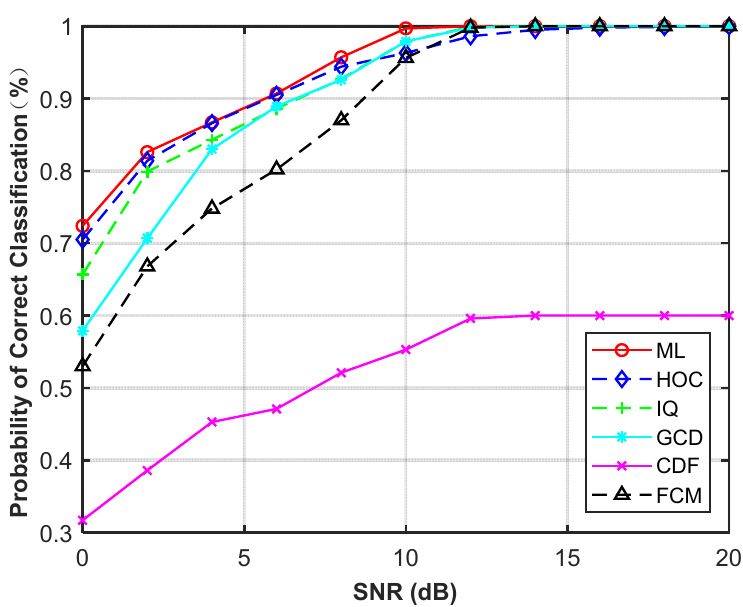
Figure 8. Probability of correct classification of PSK and QAM under AWGN versus SNR.